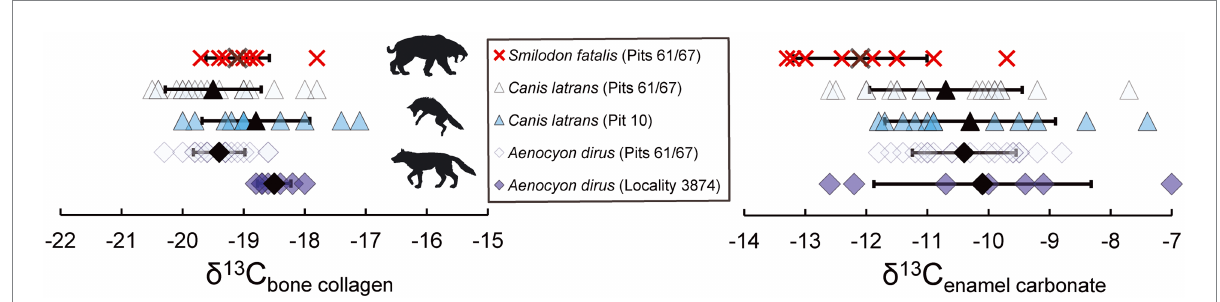
FIGURE 1 Stable carbon isotope data (collagen and carbonate) for all fossil specimens examined from Rancho La Brea ( n = 71). Mean values are denoted in bold (bars indicate 1 standard deviation, n-1). All collagen data are from bone collagen and carbonate data are from tooth enamel (lower first molars), with the exception of A. dirus from Locality 3,874 which are from incisor dentin collagen and incisor enamel, respectively. The felid S. fatalis is noted in red, with all canids noted in blue; the same shade of light blue is used for canids from pits 61/67. The scales on the x -axis are of the same magnitude for the two